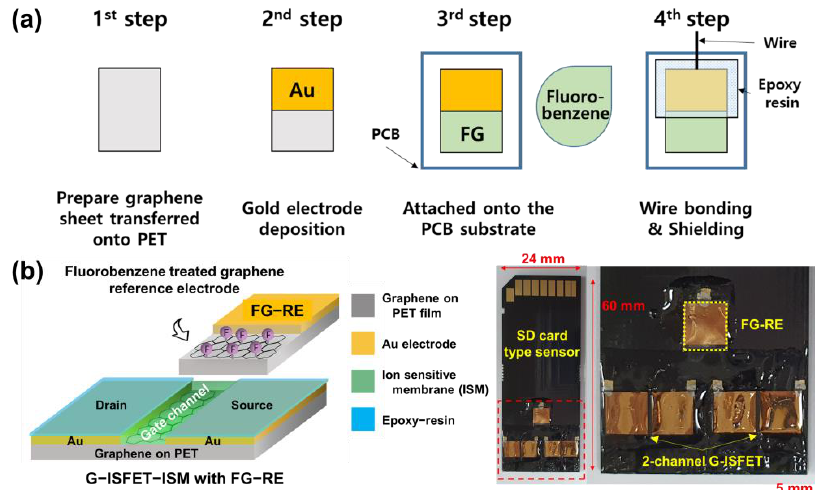
Figure 3. Schematic diagram and image of the 2D structural sensing device: ( a ) fabrication process of the fluorinated graphene reference electrode (FG–RE); ( b ) G–ISFET–ISM and FG–RE were integrated on an SD card–type printed circuit board